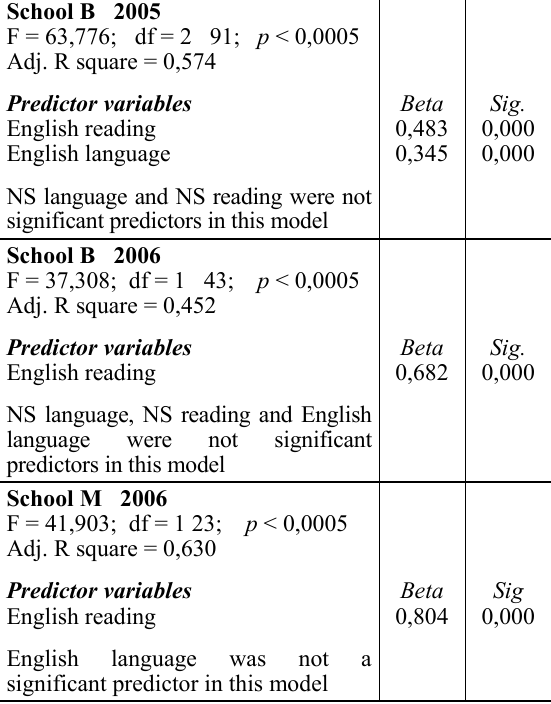
Table 4: Multiple regression predicting mathematics* Table 5: Comparison of L1 and L2 language and